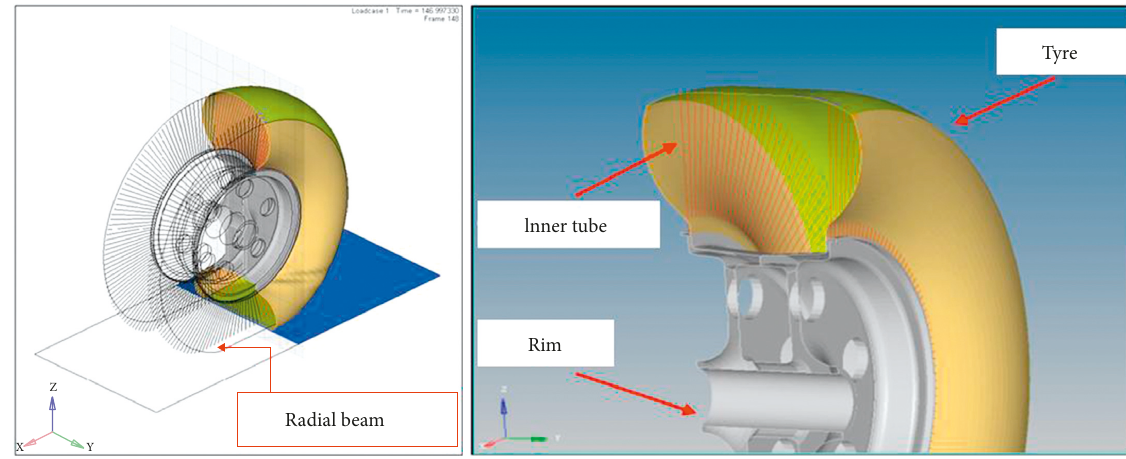
Figure 24: Tyre modelling.